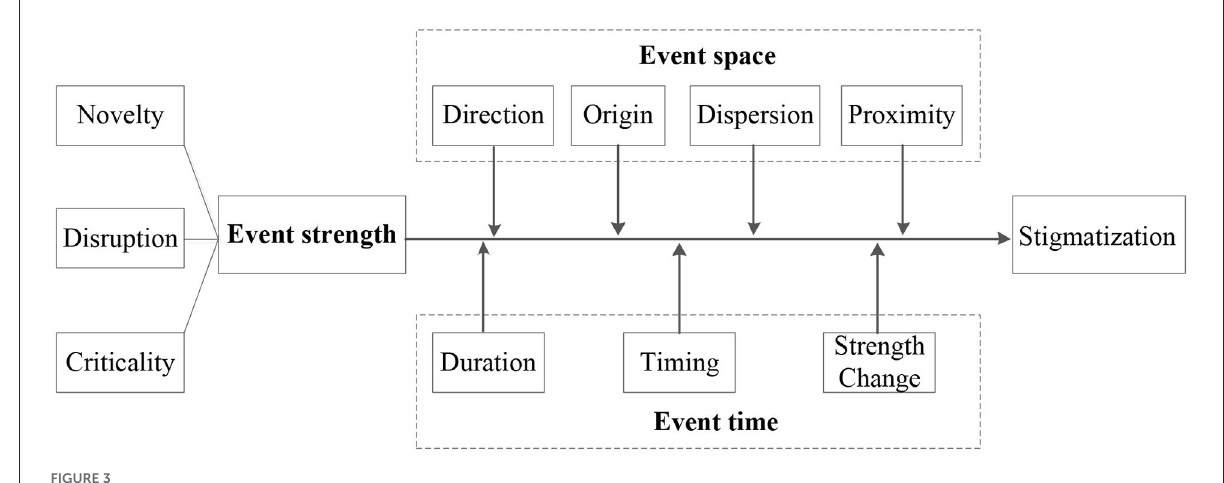
FIGURE3 Mechanism of stigma formation based on